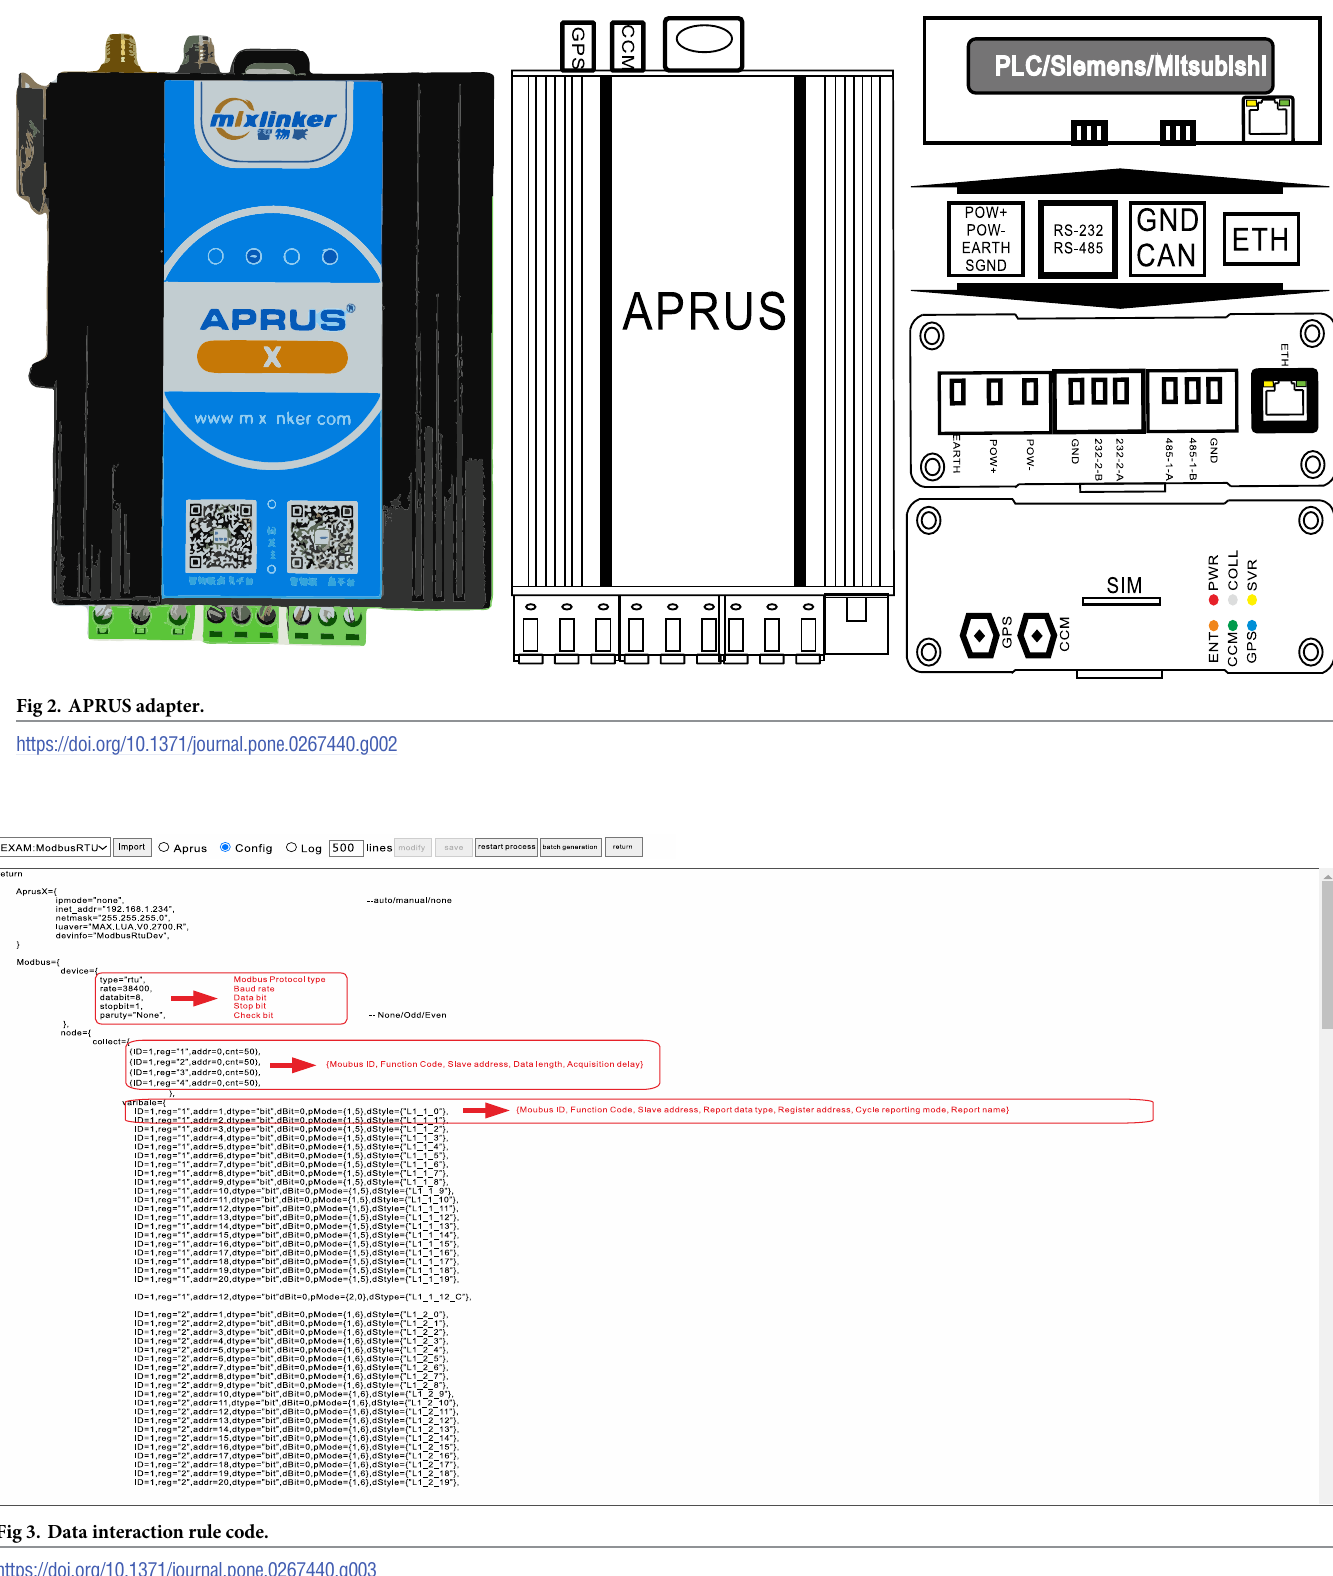
PLOS ONE | https://doi.org/10.1371/journal.pone.0267440 May 5,